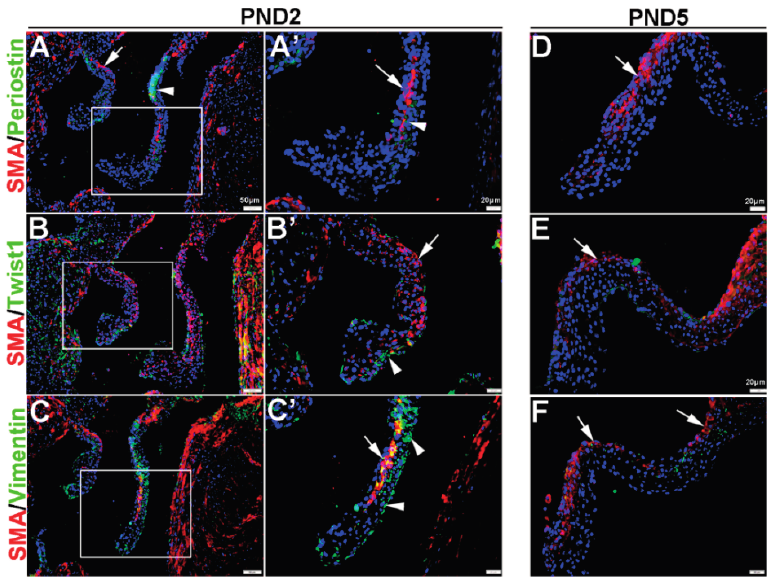
Figure 3. Characterization of VIC phenotypes in postnatal mitral valve